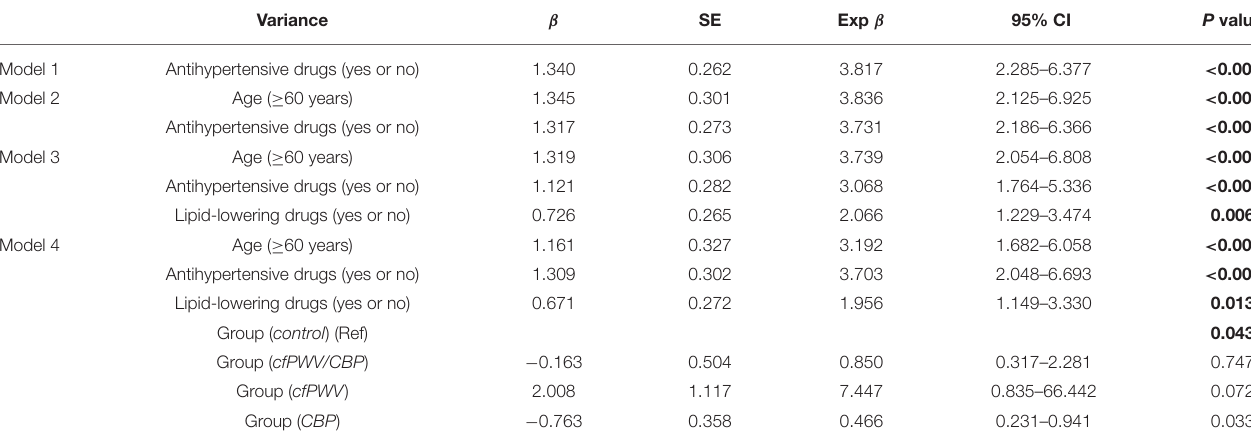
TABLE 6 | Subgroup analysis of CIMT abnormalities adjusting for age among different groups by cfPWV and CBP. Variance β SE Exp β 95% CI P